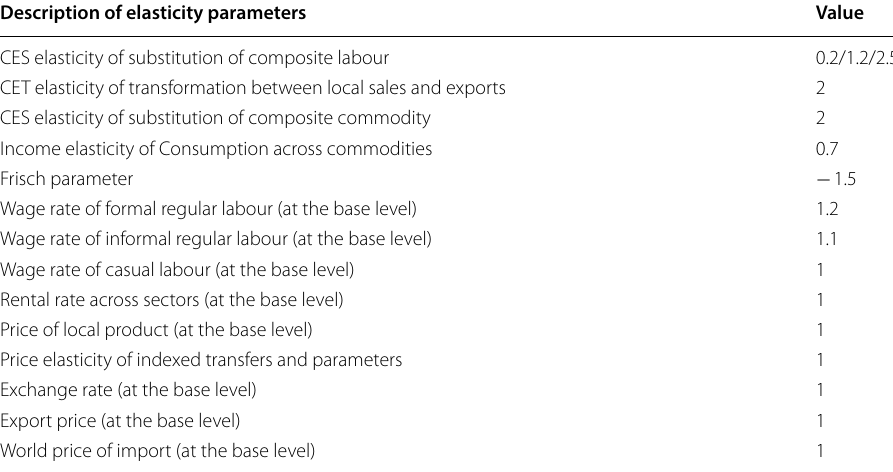
Parametric values are exogenously determined